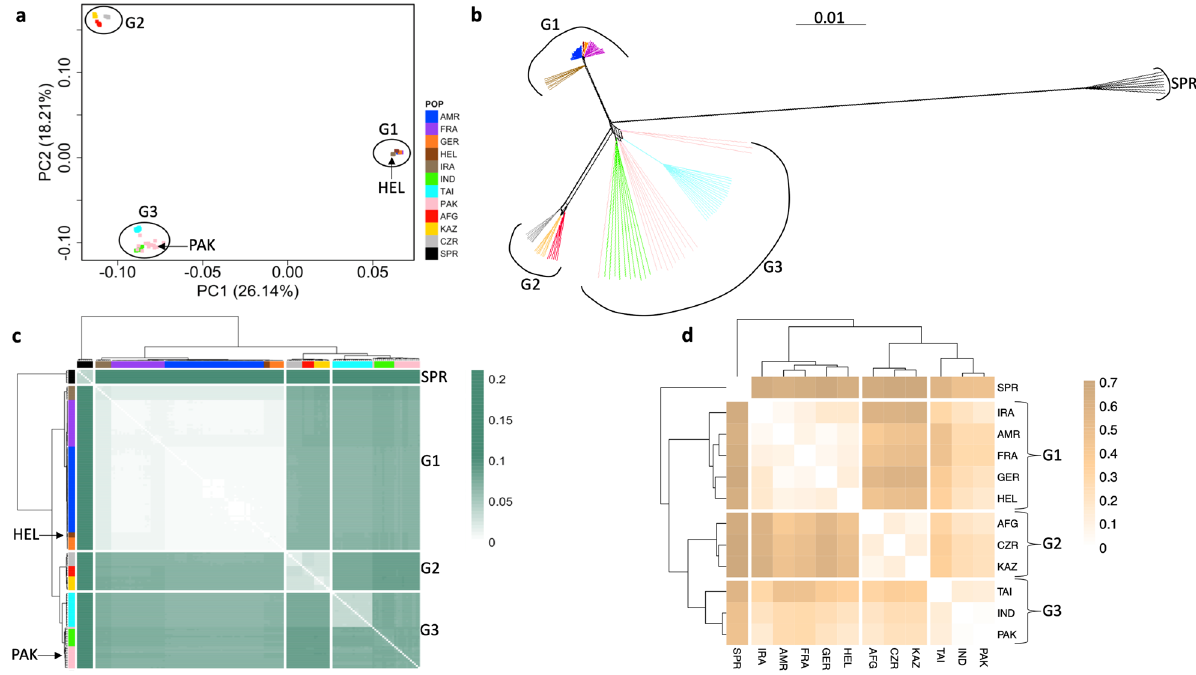
Figure 2. Genetic relationships among five putative M. musculus subspecies reveal three taxonomic groups (G1–G3). Genetic relationships were assessed via ( a ) principal component analysis, ( b ) a phylogenetic tree constructed from a pairwise distance matrix, ( c ) allele sharing distance, and ( d ) co-ancestry based on F ST . The color legend on the right side of panel ( a ) is also applicable to panels ( b ) and ( c ). G1 groups populations belonging to the DOM subspecies: America (AMR), France (FRA), Germany (GER), Heligoland (HEL), and Iran (IRA). G2 groups populations of MUS: Afghanistan (AFG), Kazakhstan (KAZ), and Czech Republic (CZR). G3 groups CAS populations: India (IND), Taiwan (TAI), and Pakistan (PAK). M. spretus (SPR) is used as an